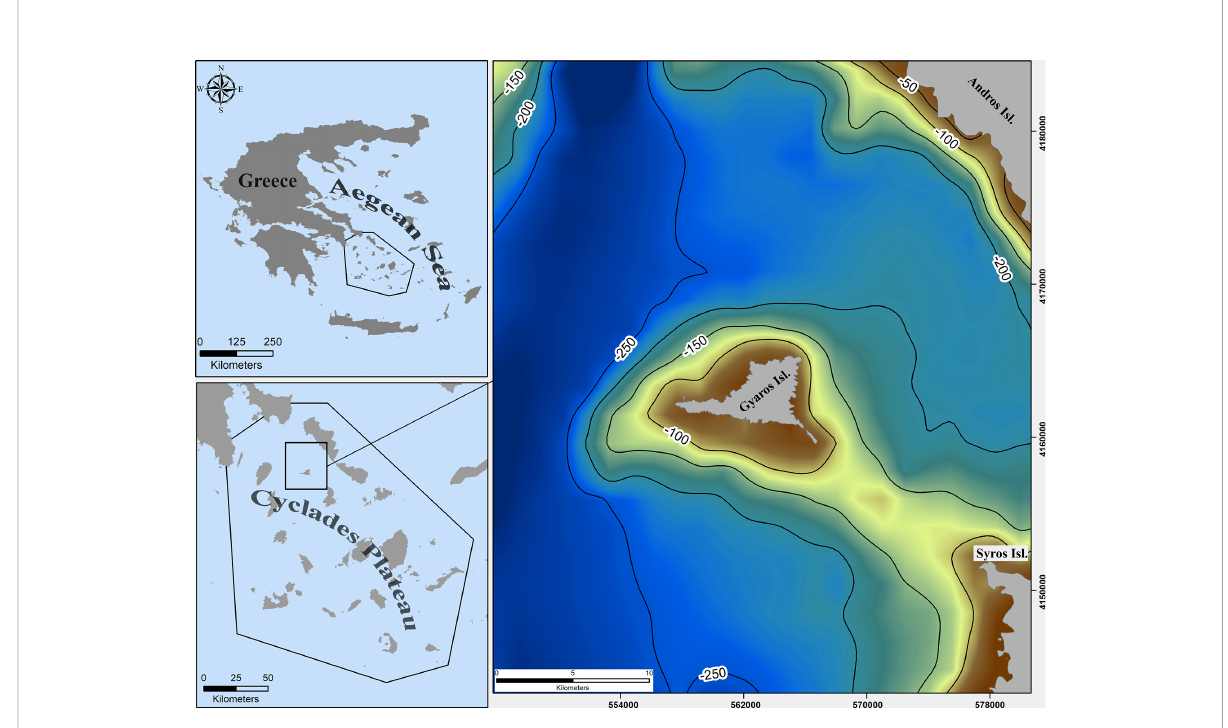
FIGURE 1 Gyaros Island location in the Cyclades plateau and the general bathymetry of the